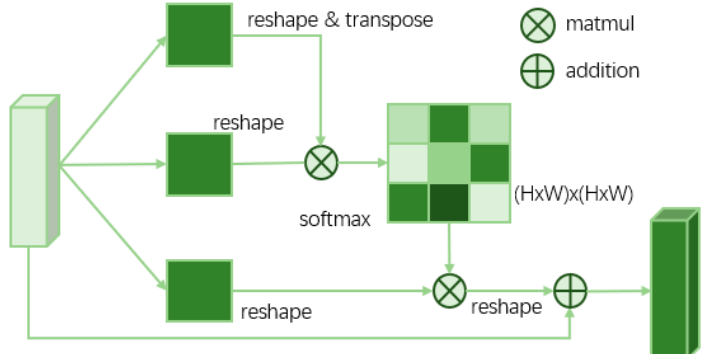
Figure 5. Architecture of the position attention module [30].